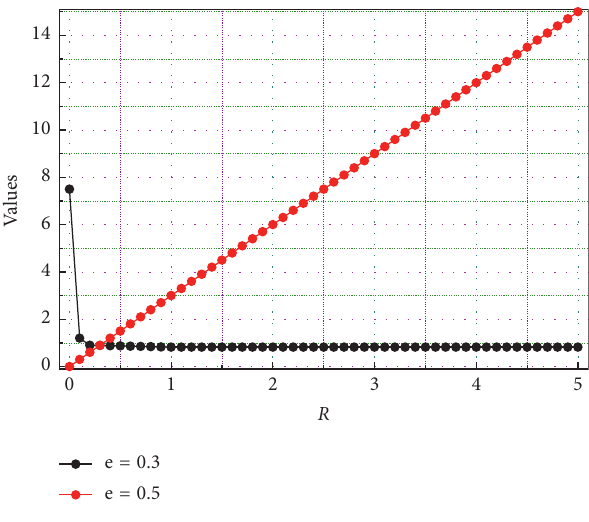
Figure 10: Total cost.